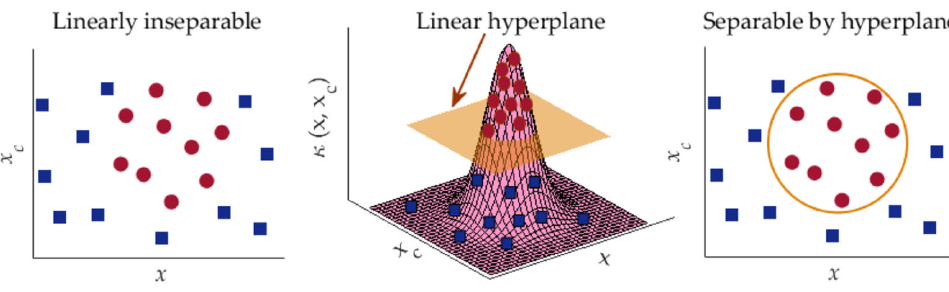
Figure 6. Data classification approach of SVM using kernel trick.